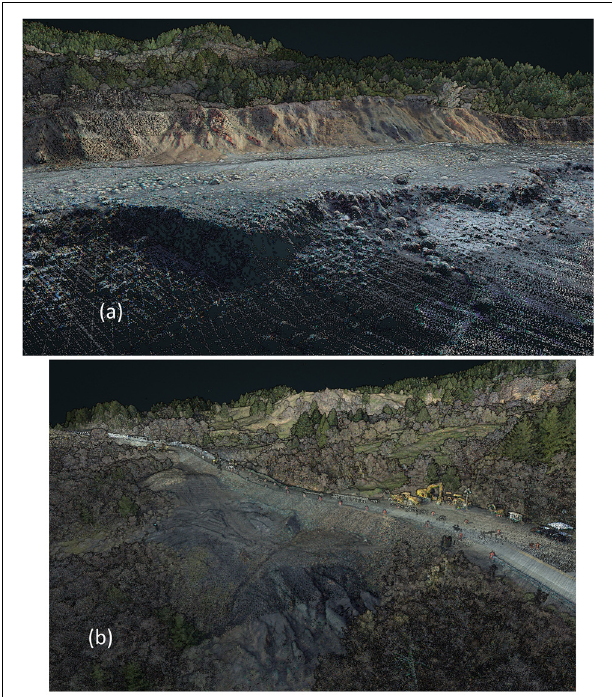
FIGURE 13 | UAS lidar point cloud of the Hooskanaden landslide showing (a) uplift at the toe on the cobble beach (RGB) and (b) reconstruction of the highway in progress at the time of